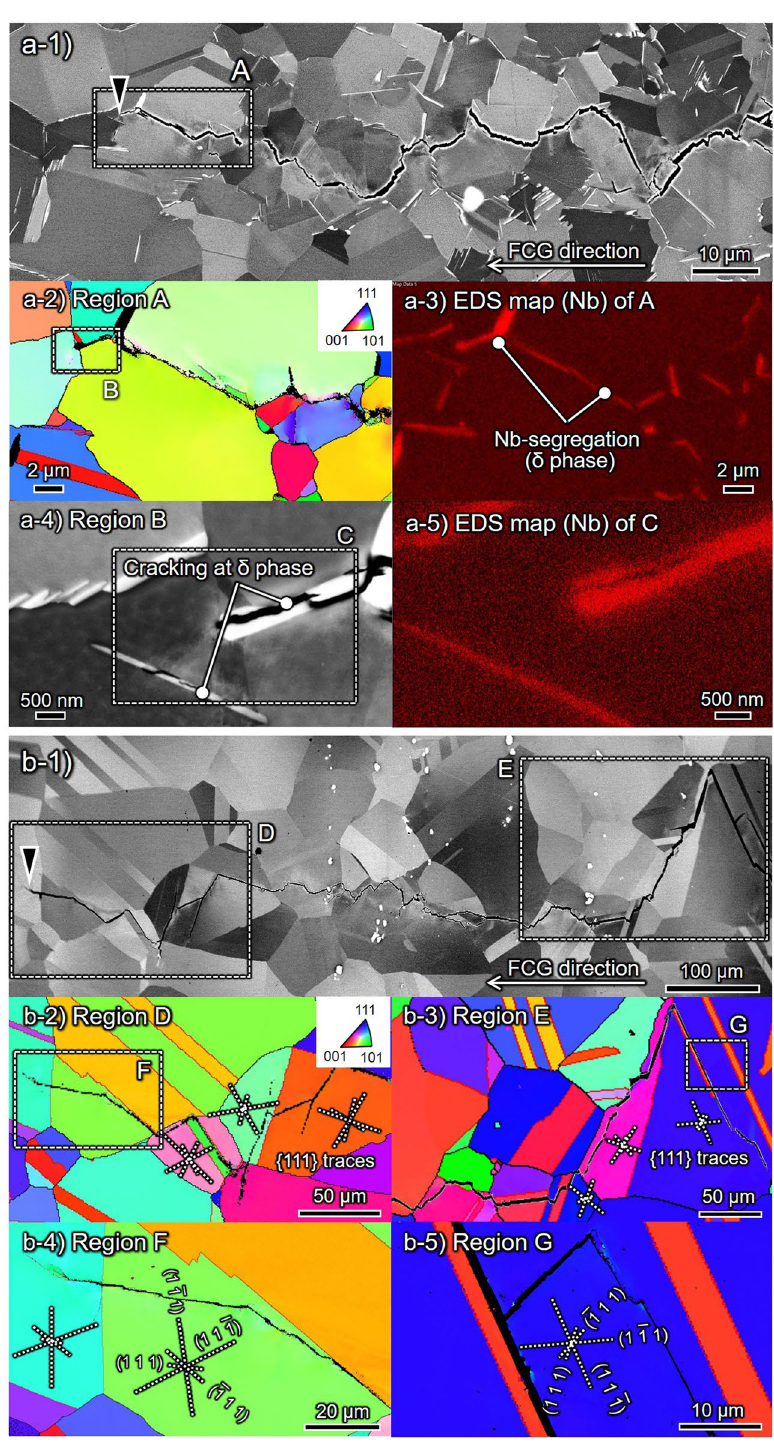
Figure 4. Crack path crystallography of ( a ) δ-FG and ( b ) CG in the presence of H subject to Δ K = 20 MPa m 1/2 : ECC images for overall aspects are in ( a-1,b-1 ). Inverse pole figure (IPF) maps with respect to the loading axis at the regions A, D, and E are in ( a-2,b-2–b-5 ) with {111} plane traces. The magnified ECC image of region B is shown in ( a-4 ), besides corresponding EDS maps of Nb at the regions A and C are in ( a-3,a-4 ),